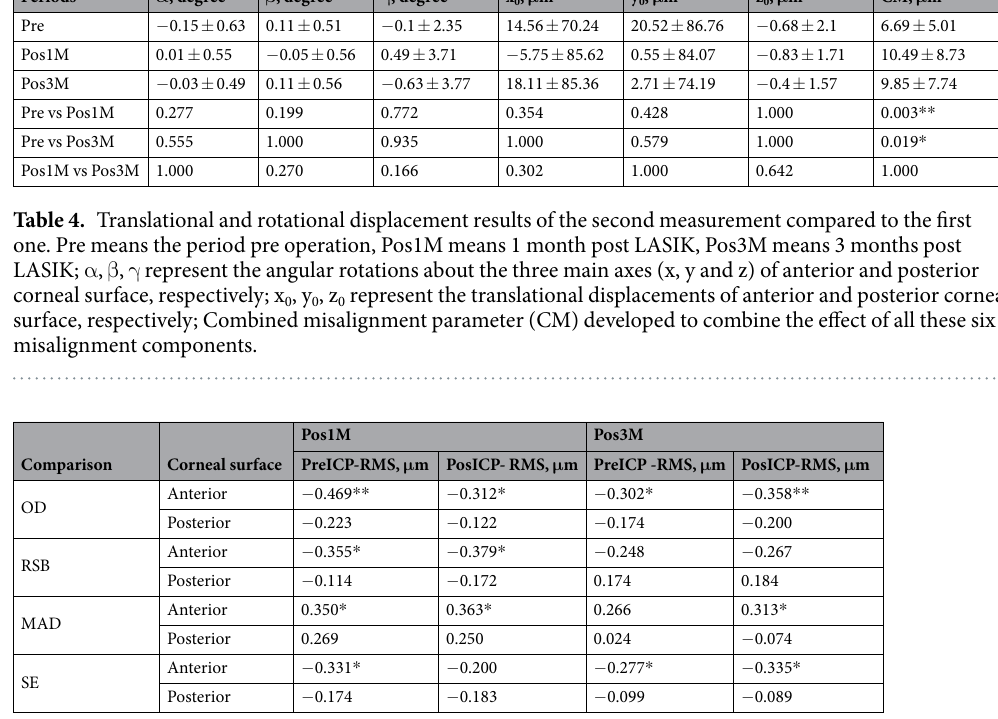
Table 5. The correlation result of PreICP-RMS and PosICP-RMS for anterior and posterior corneal surface with surgery parameters and SE in different periods post LASIK (Pos1M and Pos3M). Pos1M means 1 month post LASIK, Pos3M means 3 months post LASIK; PreICP-RMS and PosICP- RMS represent the root-mean-square error of the coordinate differences of corneal surface between two successive measurement before and after topography matching, respectively; OD represents optical diameter, RSB means residual stromal bed thickness MAD was maximum ablation depth and SE was spherical